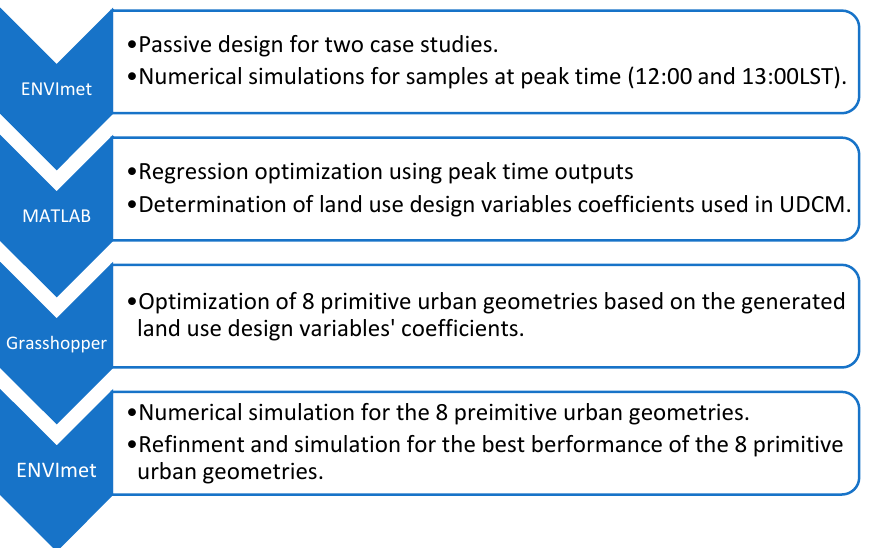
Figure 2 . UDCM research methodology workflow. Figure 2. UDCM research methodology